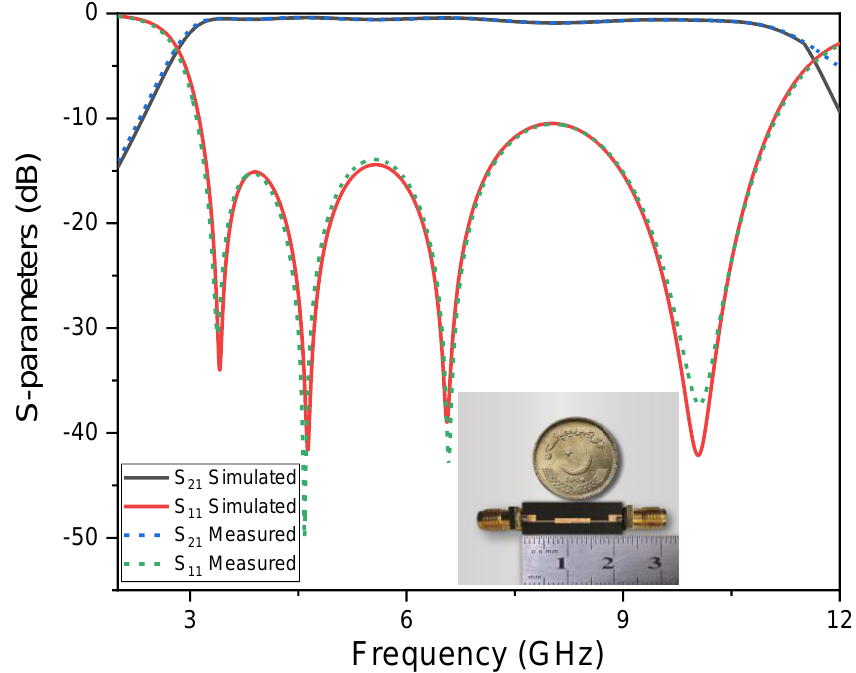
Figure 7. Simulated and measured S 11 and S 21 frequency plots of the initial UWB BPF.